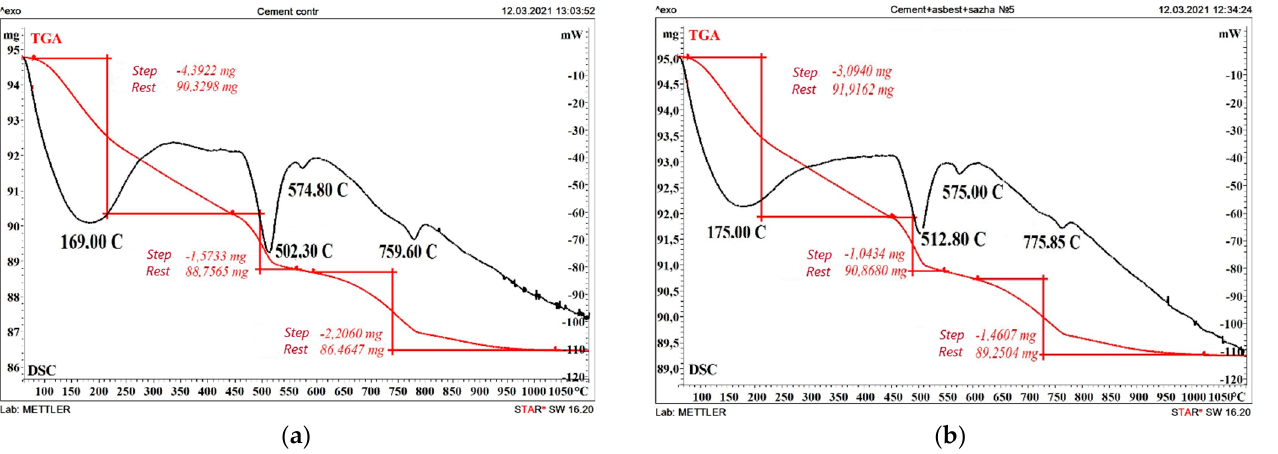
Figure 5. DSC and TGA spectrum of samples: ( a ) reference sample, ( b ) modified sample.